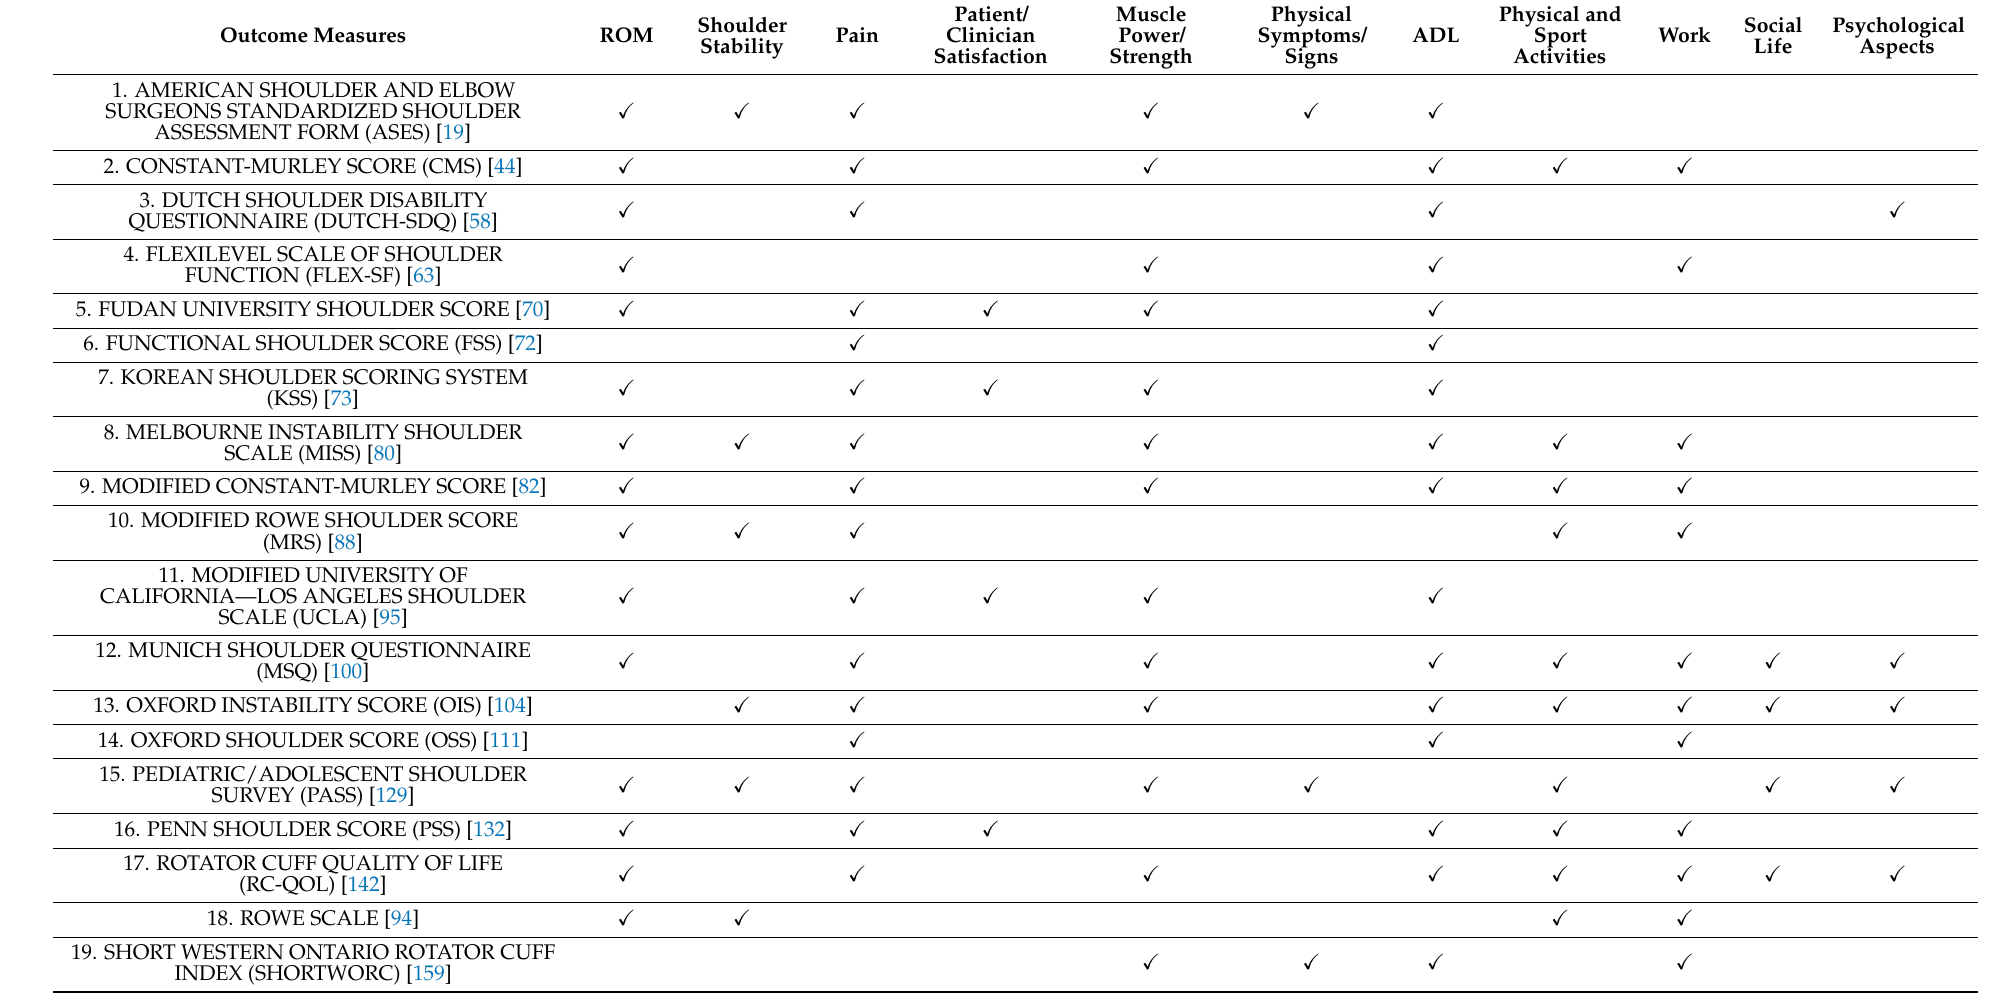
Table 6. Content approached by items and components of outcome